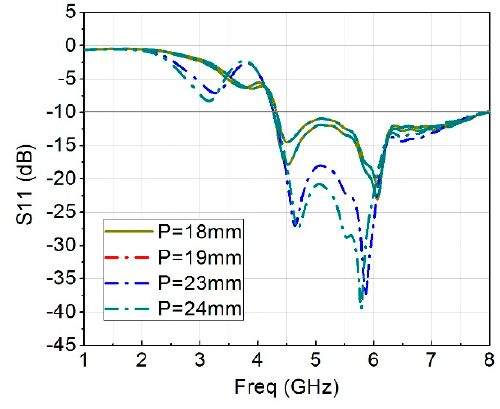
Figure 1. S11 plot for various length of P.